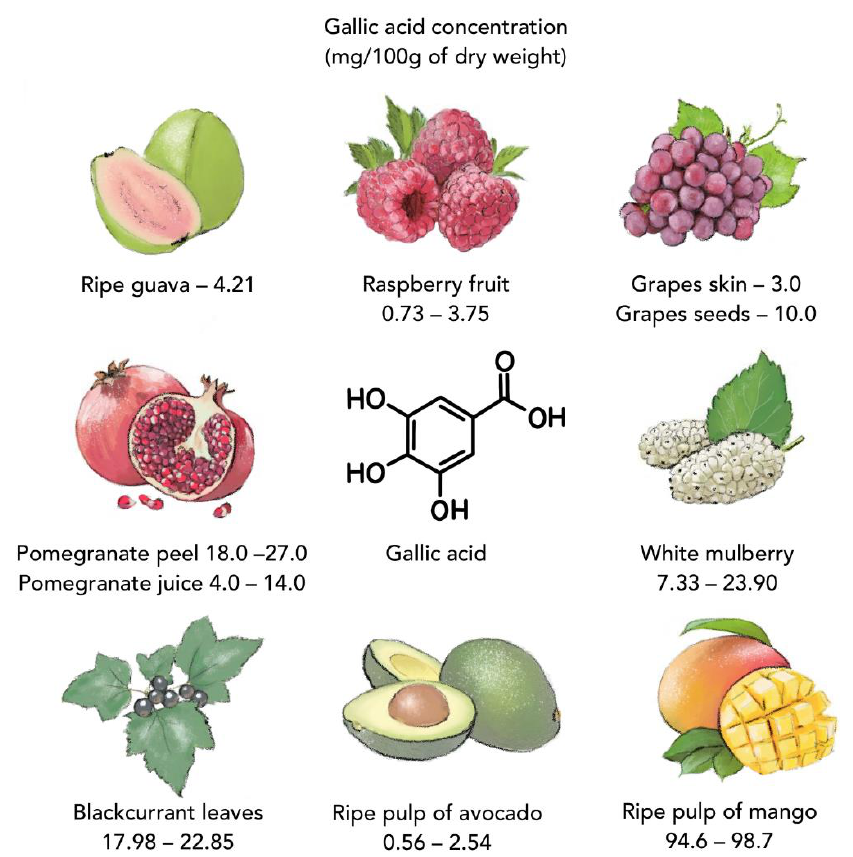
Figure 1. Some plants containing gallic acid (on the basis of data from [18–28]).